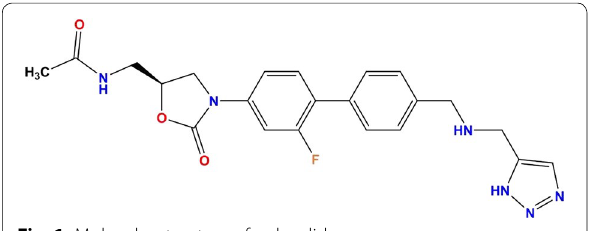
Fig. 1 Molecular structure of radezolid